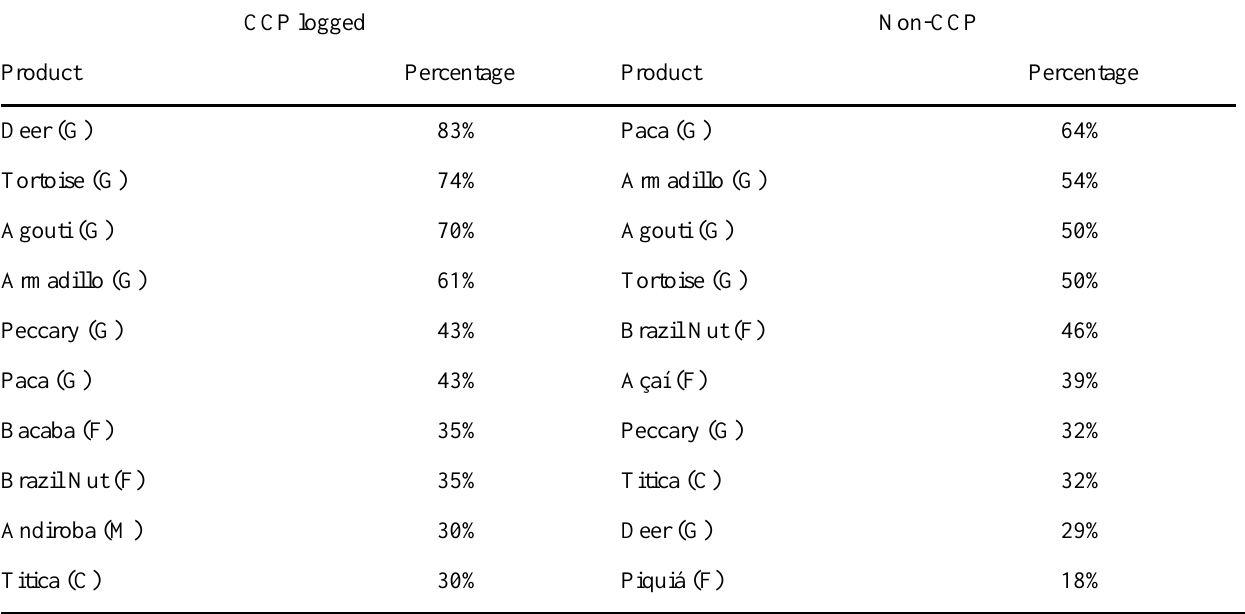
Table 2. Percentage of households recording use of the top 10 ranked NTFPs in CCP-logged and non-CCP colonist communities. (G = game animal, F = forest fruit, M = medicinal product, C = construction/handicraft material.) Percent use is calculated based on diary records (CCP logged: n = 22; non-CCP: n = 26) such that it is the number of households who recorded use of a product at least once divided by the total number of participants for CCP-logged communities and non-CCP